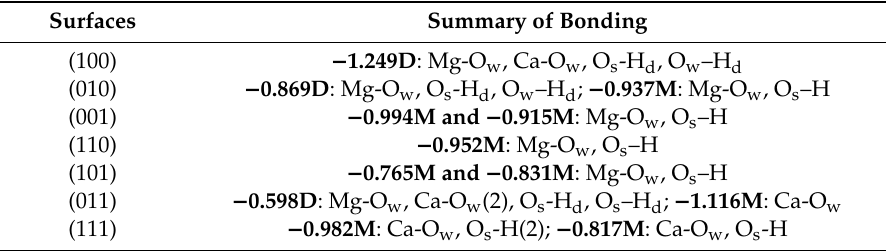
Table 3. Adsorption configurations of the H 2 O over Mg-doped β -C 2 S surfaces with respect to the adsorption energy in eV.